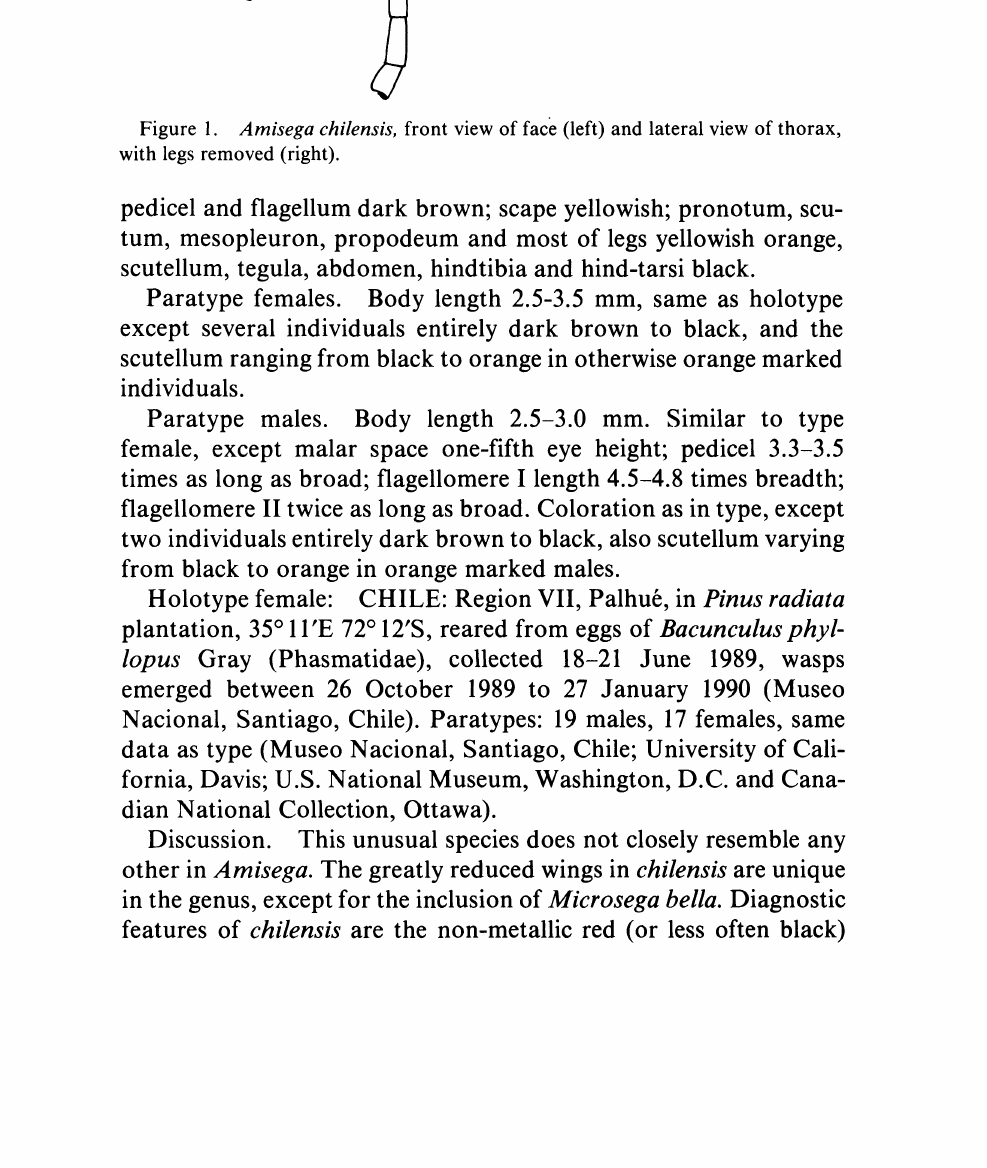
Figure 1. Amisega chilensis, front view of fac (left) and lateral view of thorax, with legs removed